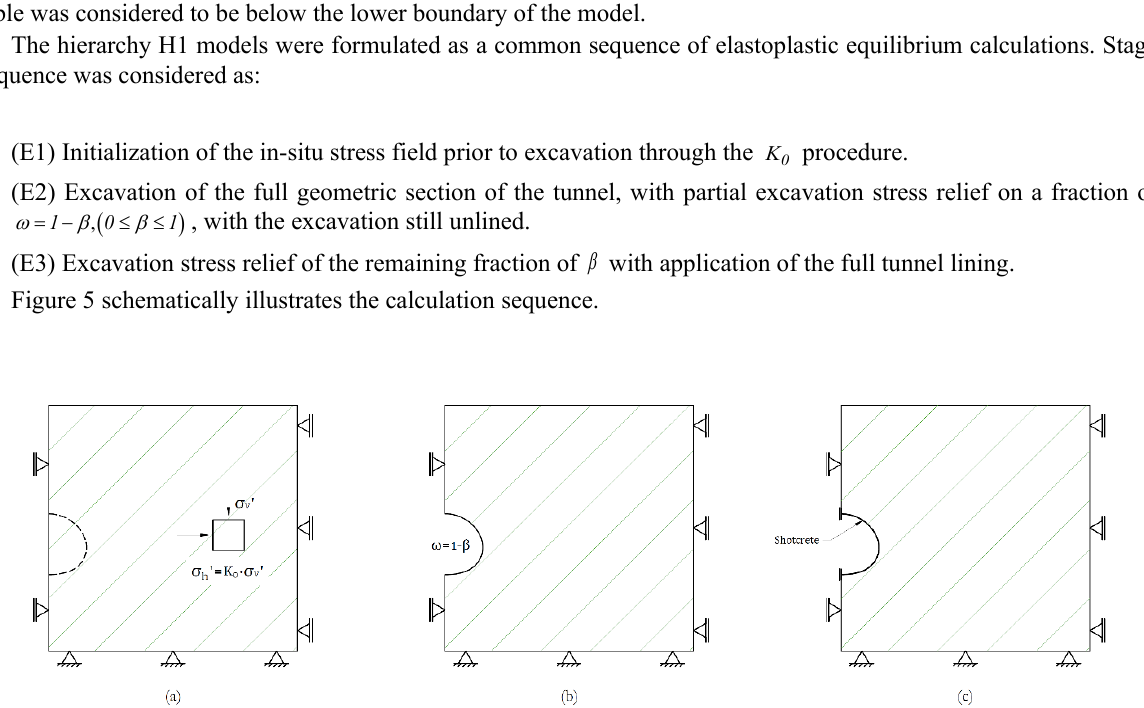
Figure 5. Calculation stages of hierarchy H1 model. (a) Stage (E1); (b) Stage (E2); (c) Stage